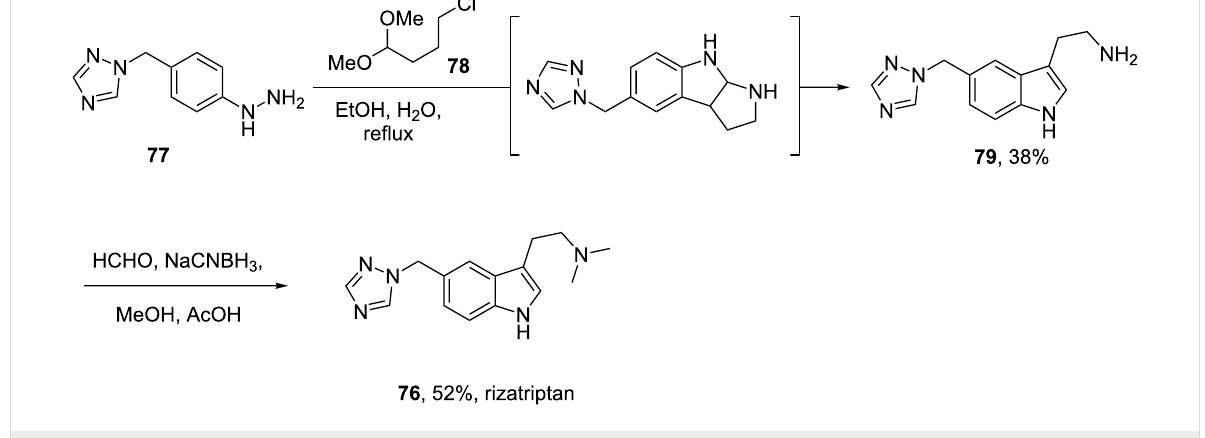
Scheme 17: Grandberg indole synthesis used in the preparation of rizatriptan.